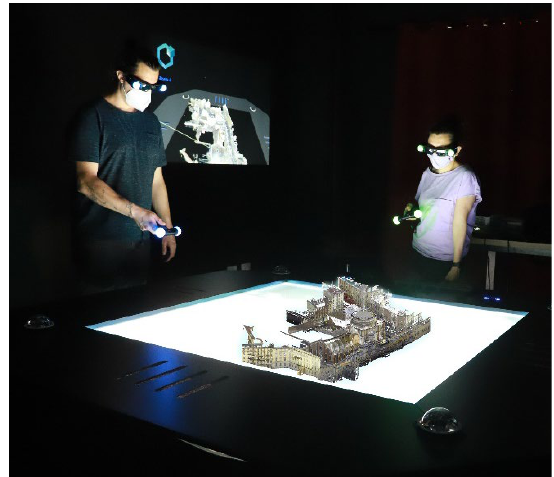
Figure 6 . Santa Maria delle Grazie RGB holographic